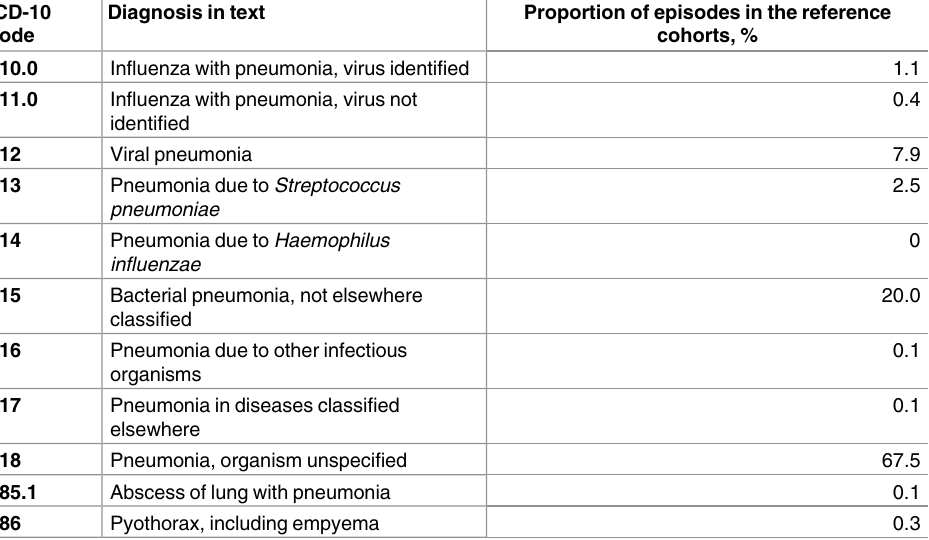
Table 1. ICD-10 codes compatible with pneumonia and their distribution in the two referencecohorts from 2003 to 2006 and 2005 to 2008. ICD-10 Diagnosis in text Proportion of episodes in the reference code